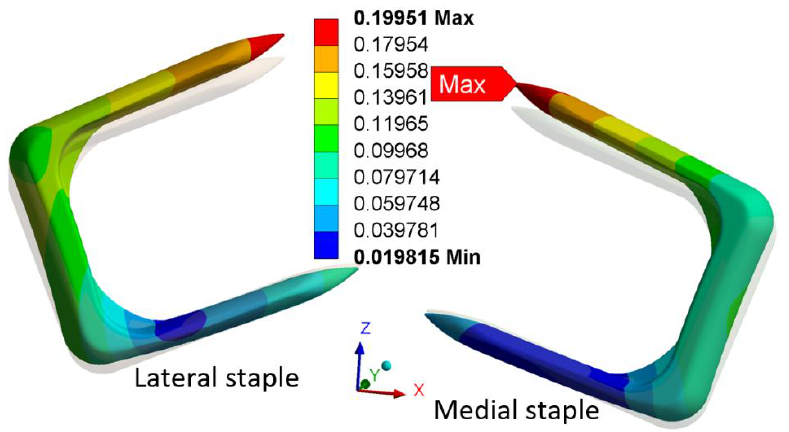
Figure 15. The total displacement of staples (mm), deformed + undeformed shape, deformation scale 10:1.